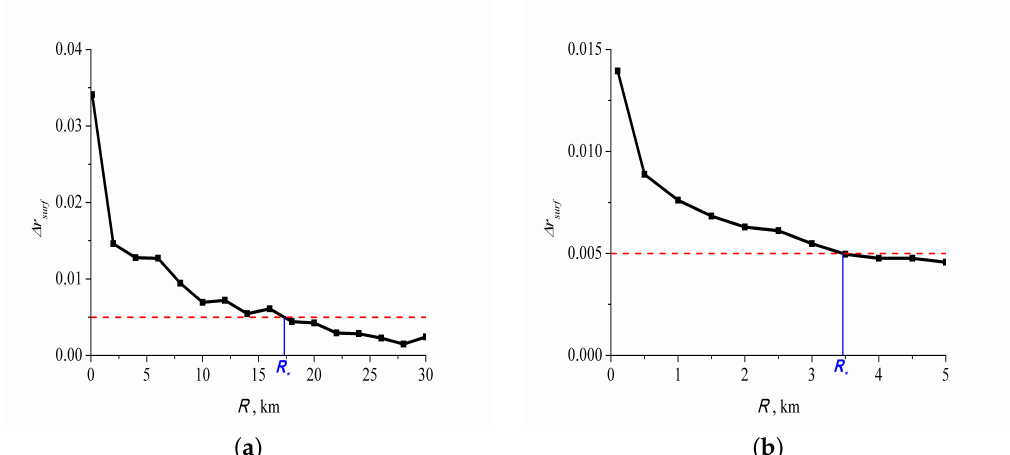
Figure 5. Dependence of the absolute error in determining the ground surface reflectance ∆ r surf on the gap radius R : ( a ) fragment 1 and ( b ) fragment